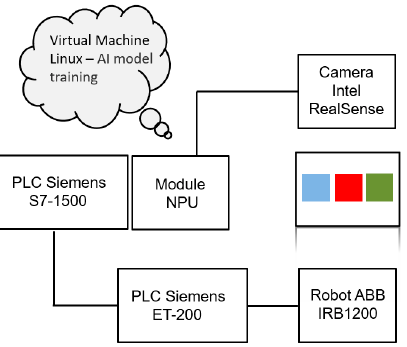
Figure 1. The implementation system configuration diagram.